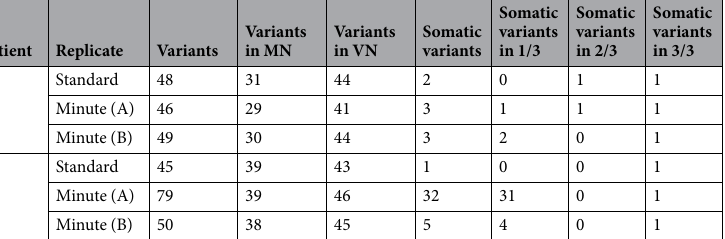
Table 2. Variant detection in primary tumor specimen replicates at standard or minute input. Number of variants detected (columns) in each replicate for each of the two patients of primary tumor specimen sequenced at standard and minute amounts (rows). The columns indicate 1) total variants detected, 2) variants in the indicated replicate also detected in the matched normal (MN) specimen (if available), 3) variants in the indicated replicate also present in at least one Virtual Normal (VN) genome, 4) variants classified as somatic variant (criteria in manuscript), 5) somatic variants in only the indicated replicate (one out of three) 6) somatic variants in the indicated and in one additional replicate (two out of three) and 7) somatic variants in the indicated and in all additional replicates (two out of